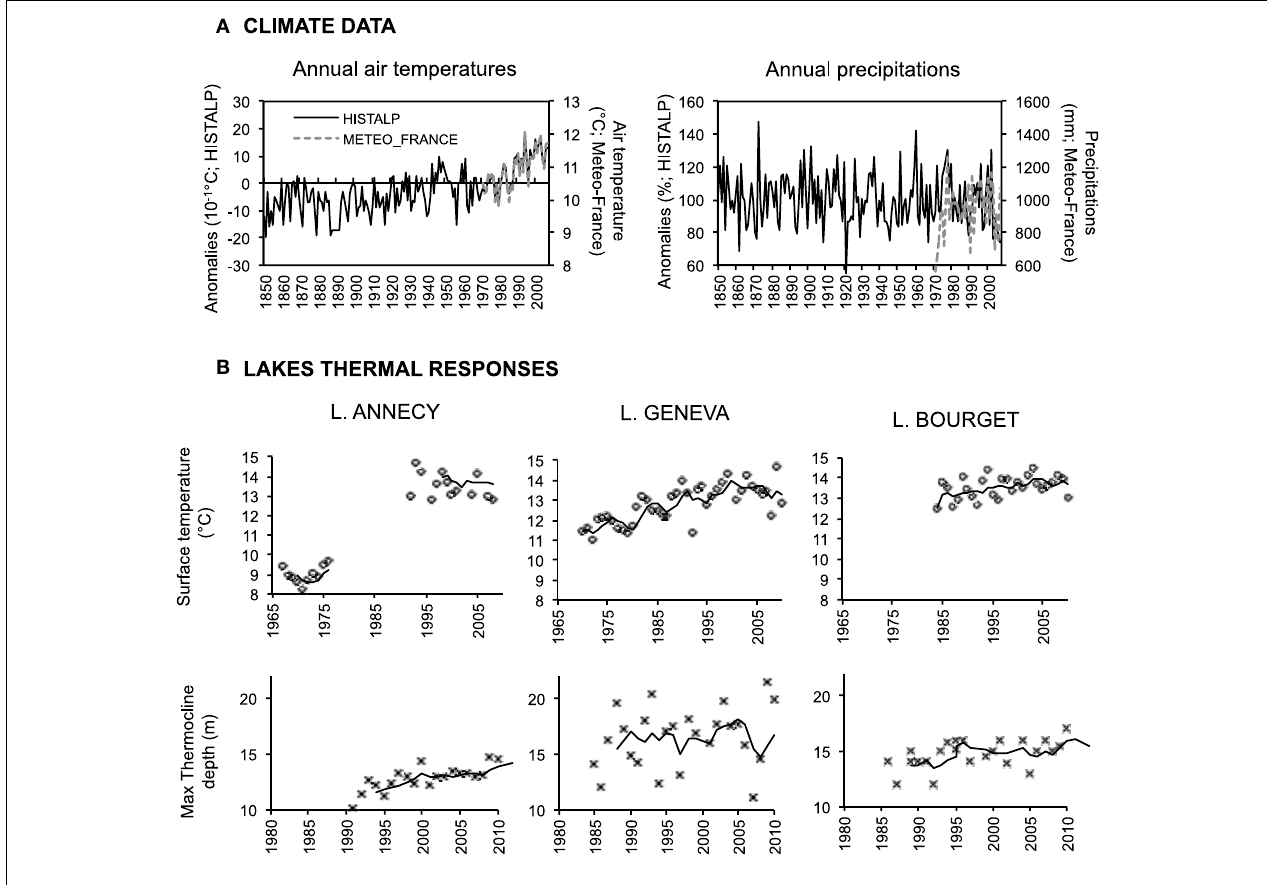
FIGURE 2 | (A) Climate variability over the three lakes for the last 150 years as extrapolated from HISTALP and comparison to locally monitored data (Meteo-France). (B) Changes lake key thermal characteristics, upper panel: